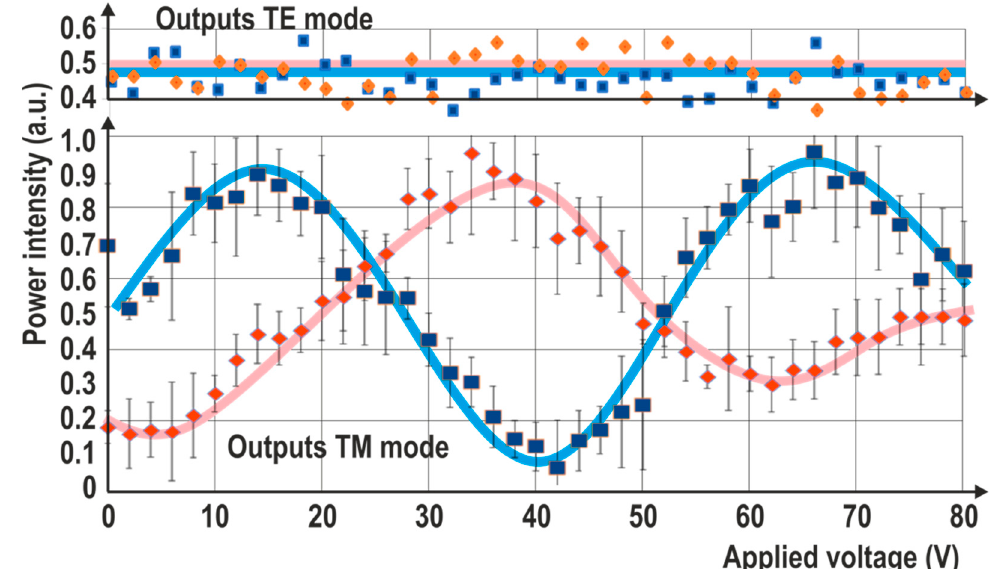
Figure 5. Transmission variation as a function of the applied field for TE (top) and TM (bottom) light modes. Only the TM mode is affected by the liquid crystal reorientation, since TE always experiences the LC ordinary index.